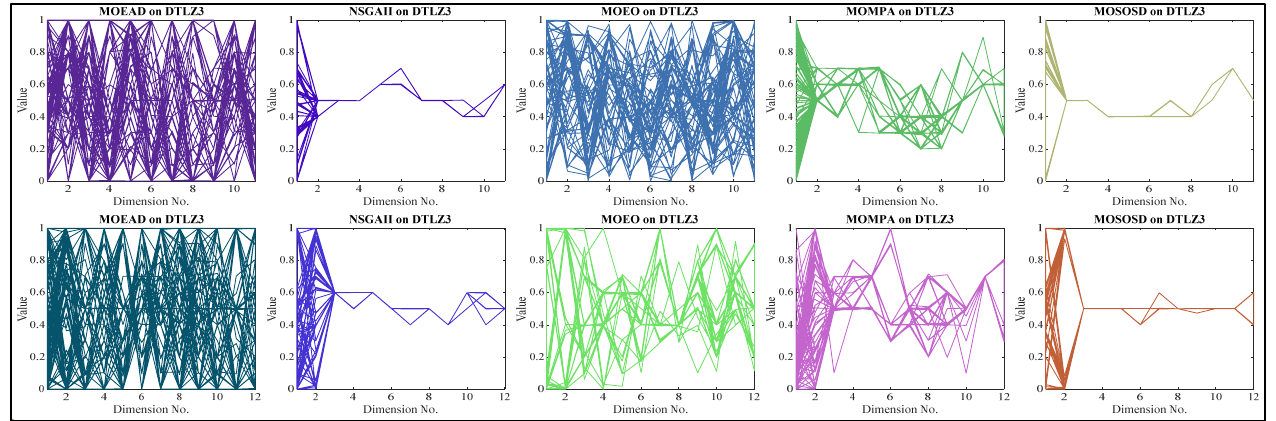
Figure 11. The dimension curve of MOEA/D, NSGA-II, MOEO, MOMPA, and MOSOS/D for DTLZ3 at M = 2, 3.